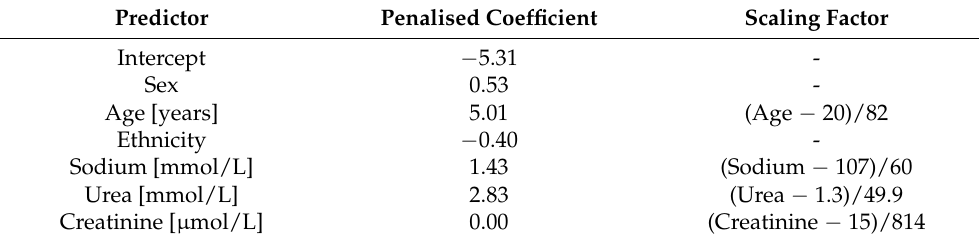
Table 2. Logistic regression penalised coefficients and scaling factors. Predictor Penalised Coefficient Scaling Factor Intercept − 5.31 - Sex 0.53 - Age [years] 5.01 (Age − 20)/82 Ethnicity − 0.40 - Sodium [mmol/L] 1.43 (Sodium − 107)/60 Urea [mmol/L]